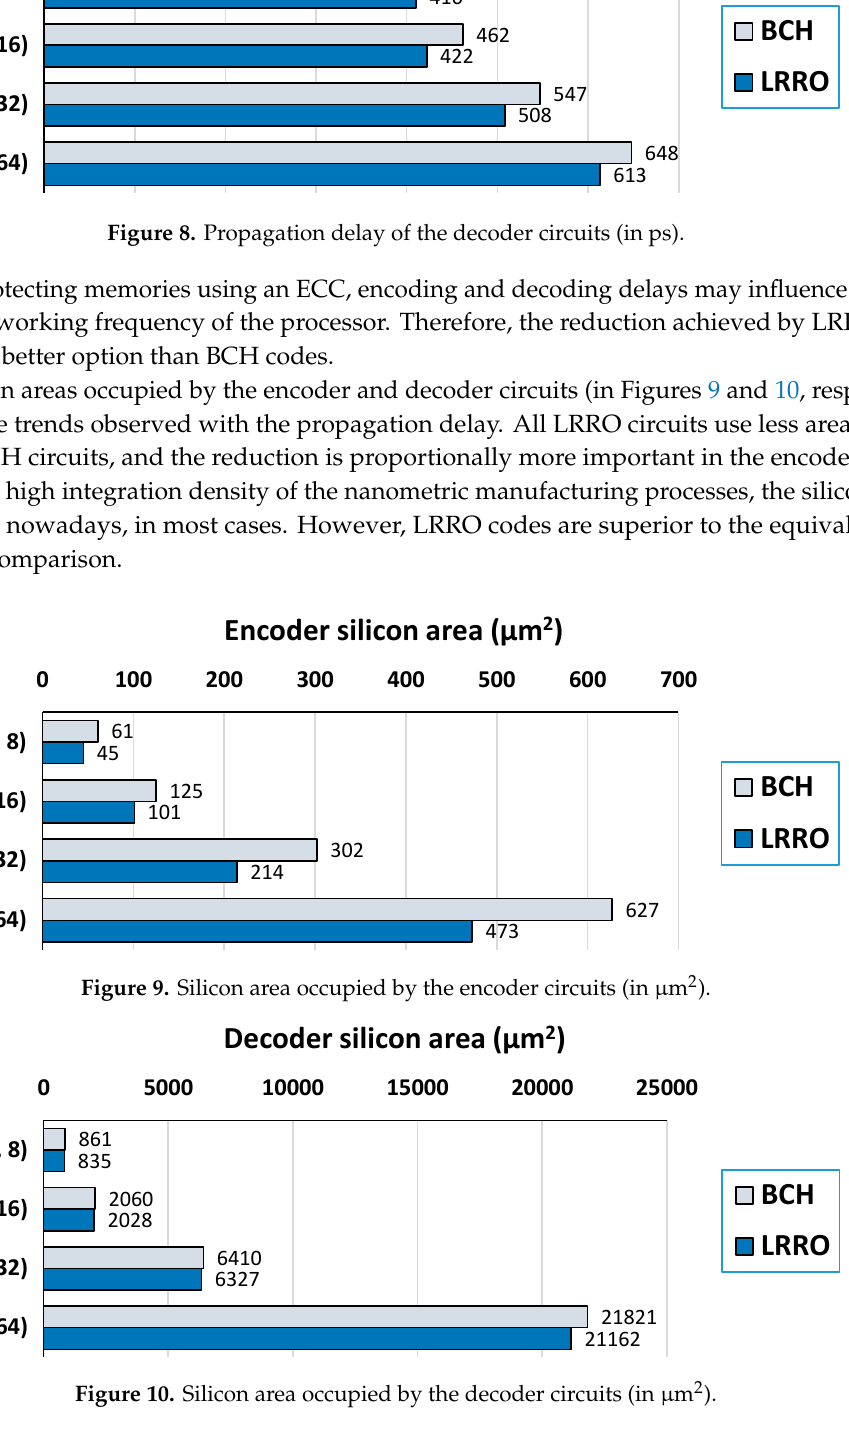
Figure 10. Silicon area occupied by the decoder circuits (in µm 2 ).